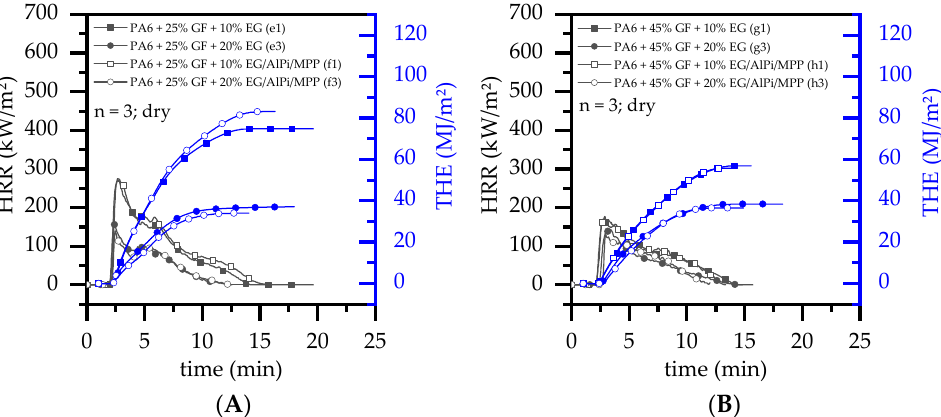
Figure 5. Representative selection of cone calorimeter (50 kW/m 2 ) results displayed over time for ( A ) net PA6 and PA6 containing 25 wt.% and ( B ) 45 wt.% GF (15 vol.% and 30 vol.%) as well as 10